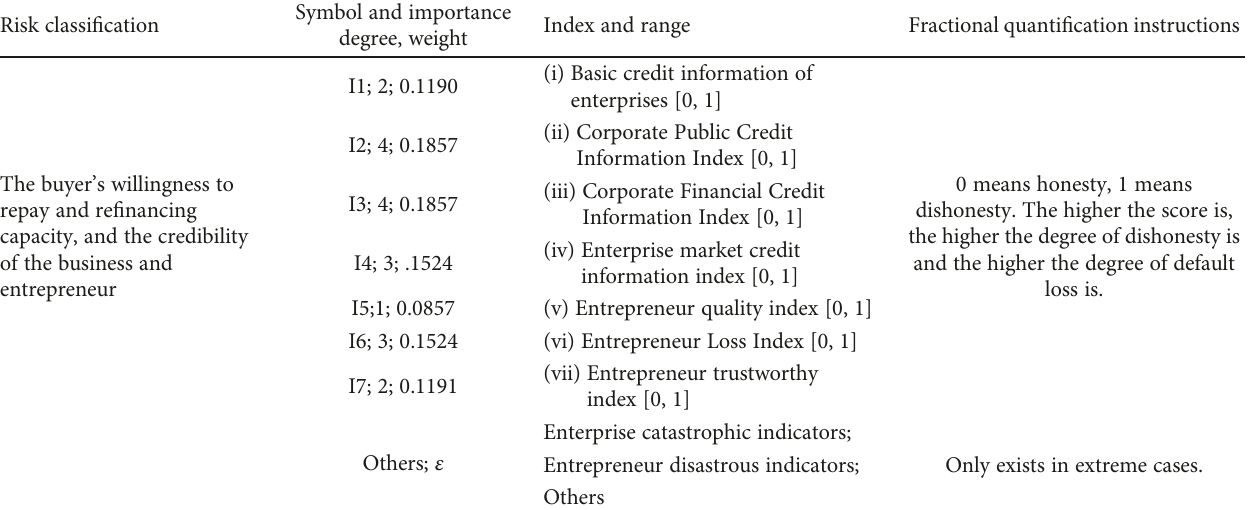
Table 4: Buyer non fi nancial index